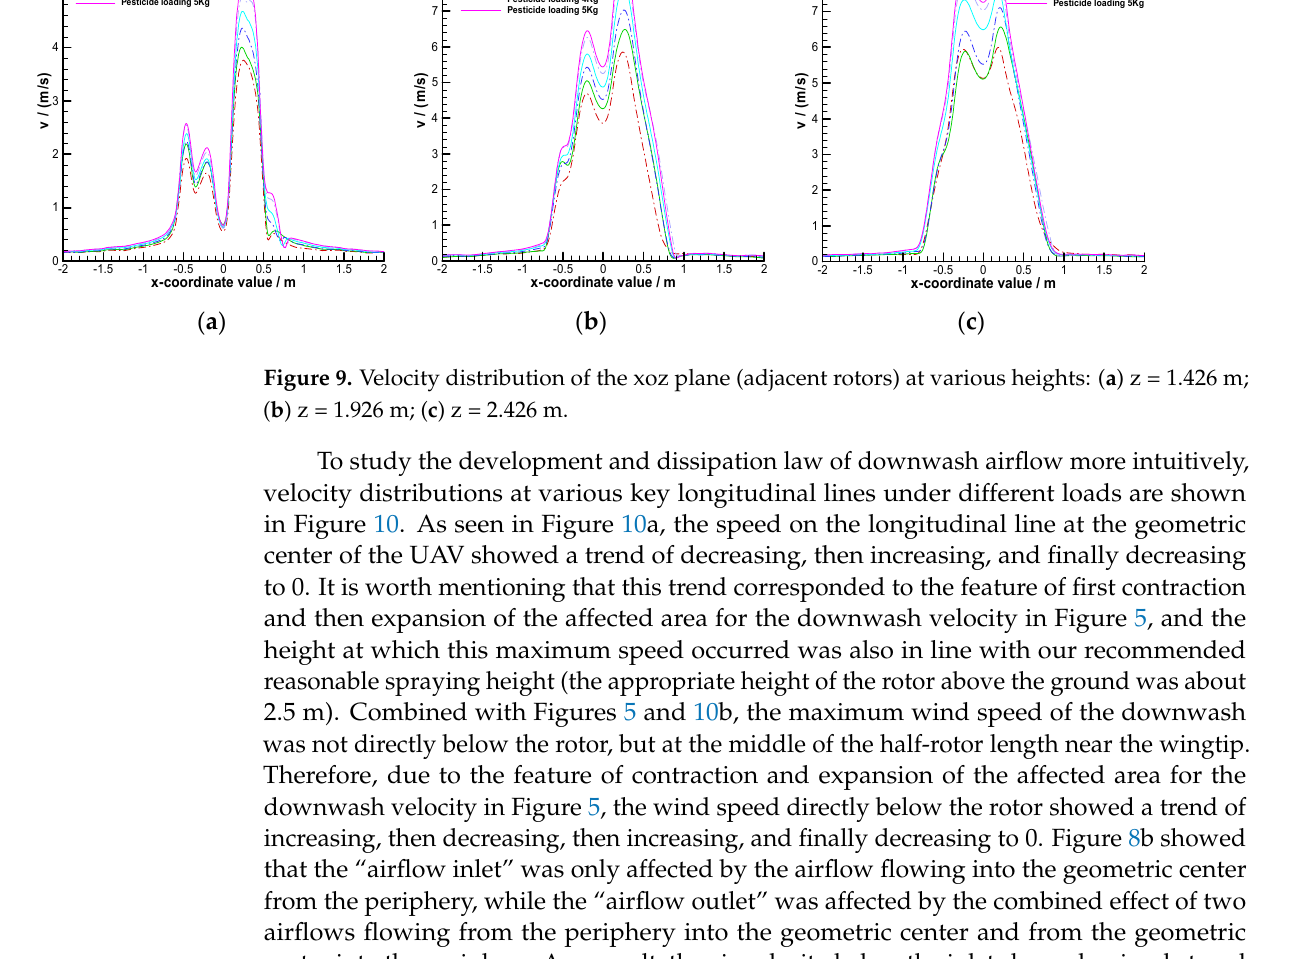
( d ) Figure 10. Velocity distribution at various longitudinal line under the different loads: ( a ) Longitu ‐ dinal line at the geometric center of the UAV; ( b ) Longitudinal line at the geometric center of the